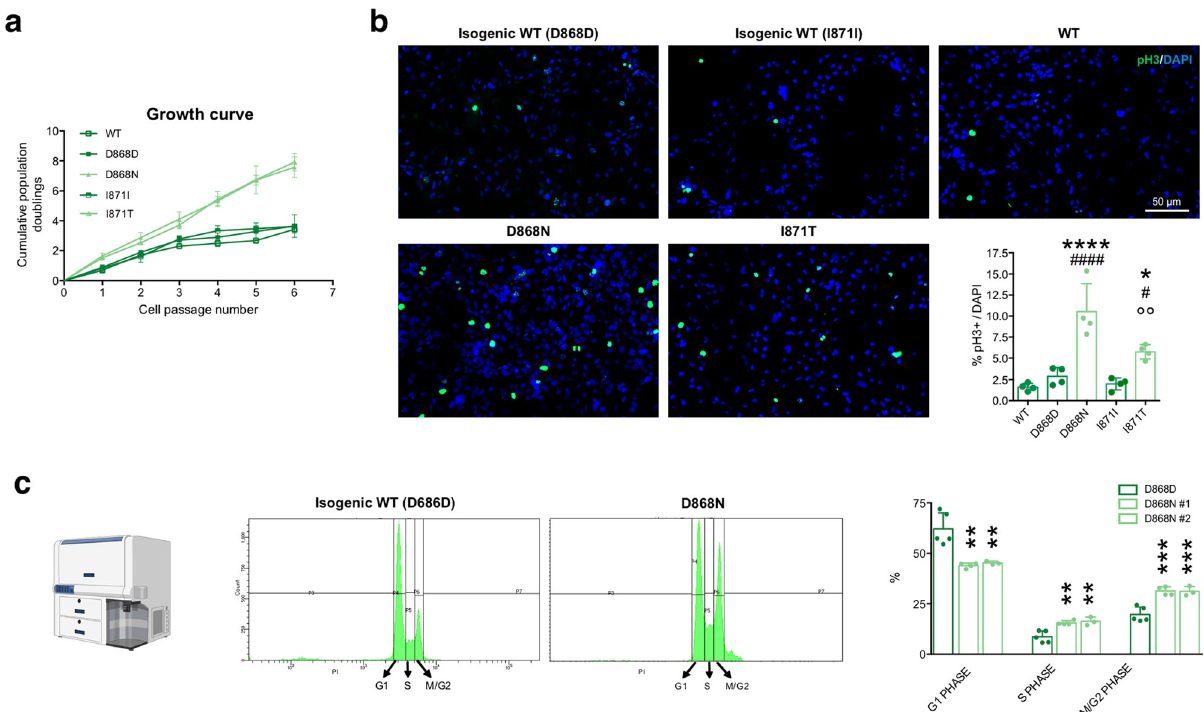
Fig. 3 SGS NPCs display overproliferation. a Growth curve analysis of WT, isogenic control, and mutant NPCs See Supplementary Dataset 3 for statistical analysis. n = 3. b NPC proliferation assay by phosphorylated H3 (pH3 Ser10) immunostaining and quanti fi cation in WT, isogenic control, and mutant NPCs. * indicates statistic test between isogenic cell line pairs, # refers to the comparison between each mutant cell line with the unrelated WT one, ° refers to the comparison between mutant NPCs. P < 0.0001; WT vs. D868D P = 0.8012; WT vs. D868N #### P < 0.0001; WT vs. I871I P = 0.9972; WT vs. I871T # P = 0.0202; D868D vs. D868N **** P < 0.0001; I871I vs. I871T * P = 0.0377; D868N vs. I871T °° P = 0.0068. See Supplementary Fig. 2f for WT vs. MUT comparisons. n = 4. Images taken at the same magni fi cation. c Cell cycle analysis by PI staining and FACS quanti fi cation; graphs showing different peak distribution indicating different cell cycle phases in isogenic control and mutant NPCs. Bar graph shows the percentage of cells present in each phase in D868D and D868N cells. G1: D868D vs. D868N #1 **** P = <0.0001, D868D vs. D868N #2 **** P < 0.0001; S: D868D vs. D868N #1 * P = 0.0311,